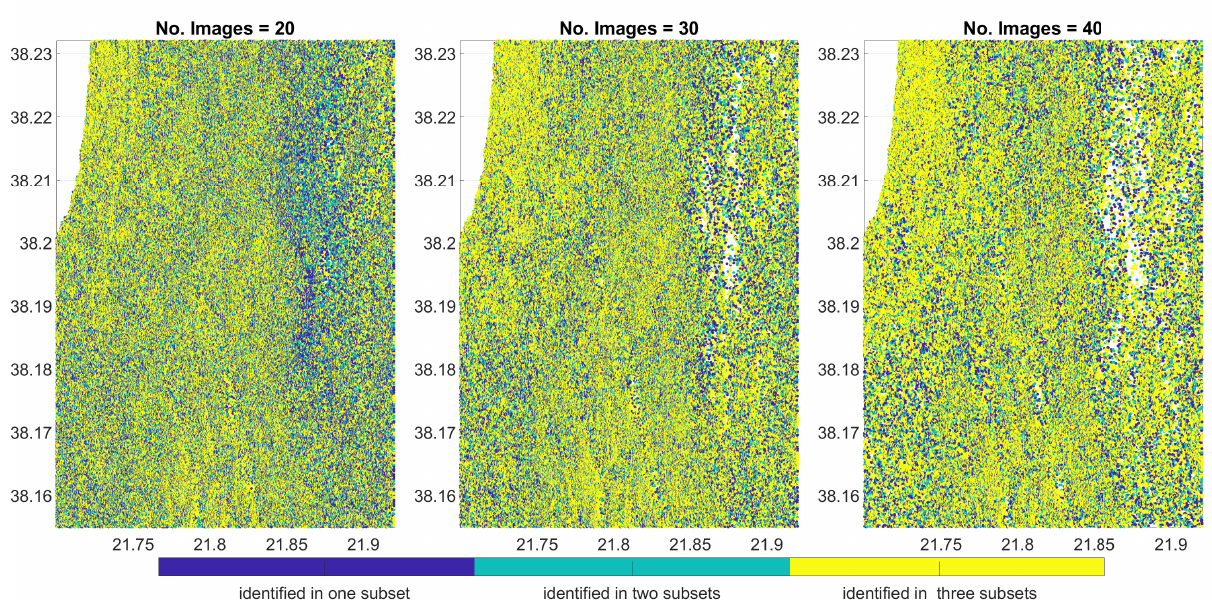
Figure 6. The PSC, which are identified in one subset (dark blue), in two (petrol) or in three (yellow) subsets, are featured in the maps. There is a map for each subset size, starting with the size 20 images on the left side, 30 images in the middle and 40 images on the right side (Approach